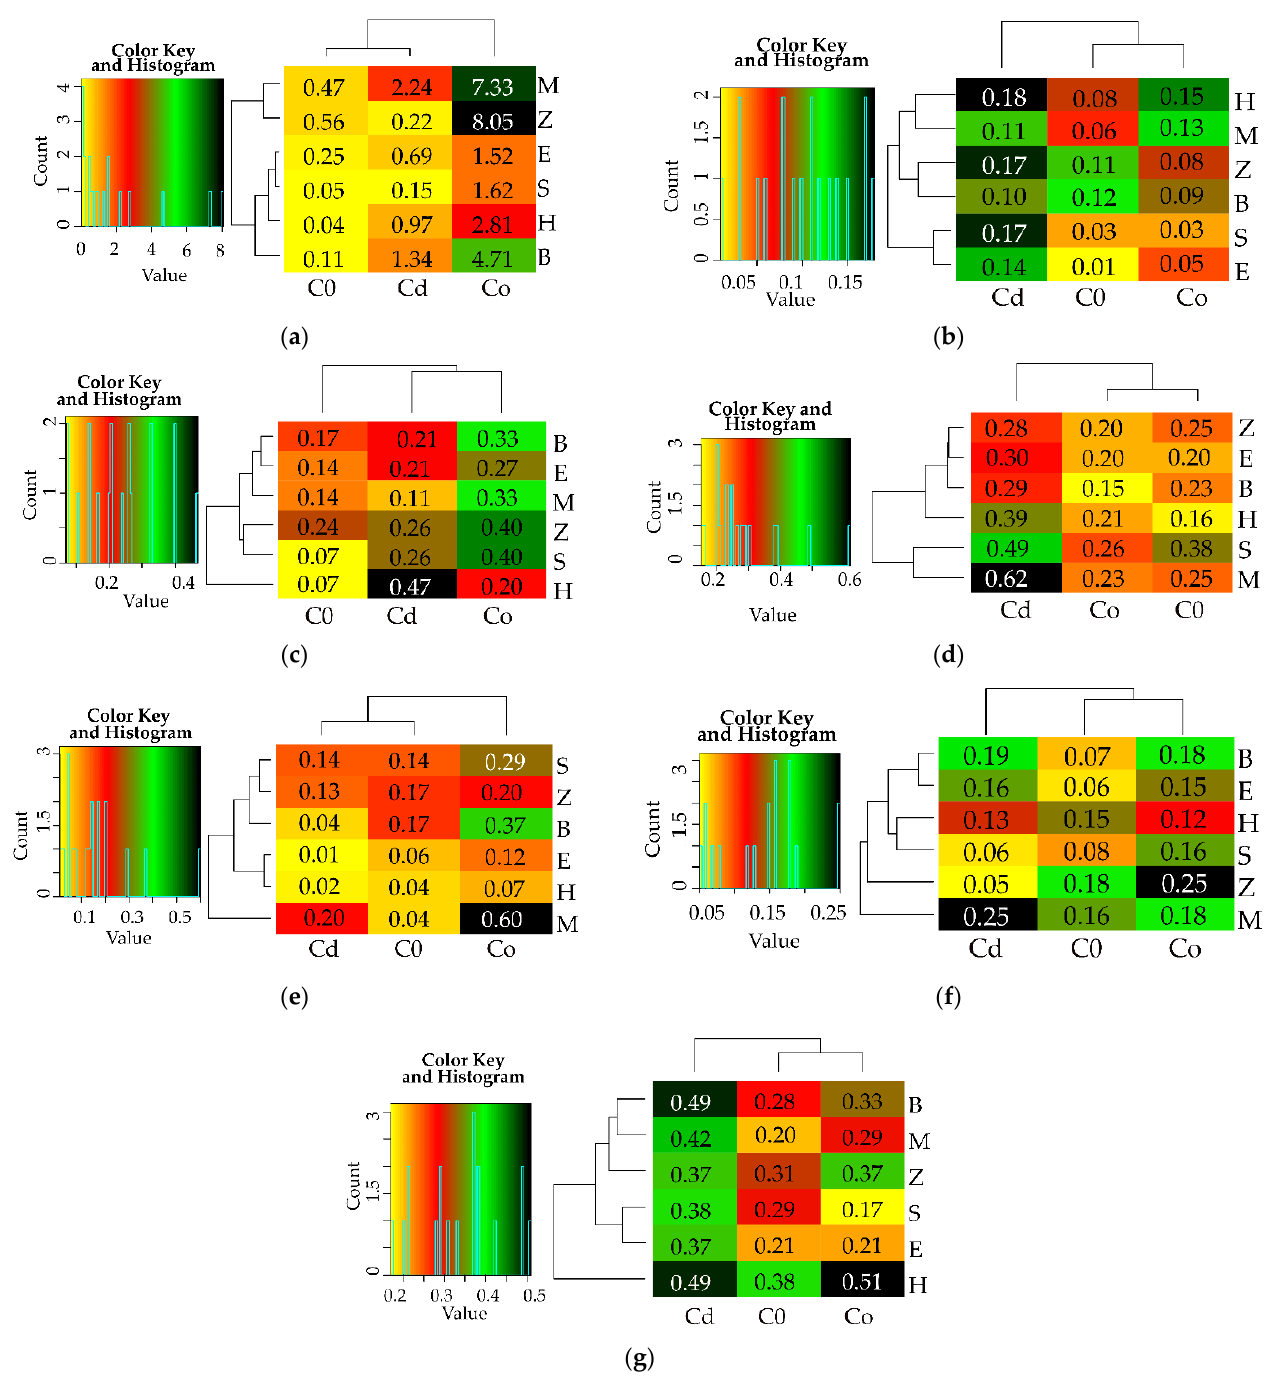
Figure 5. Indexes of the influence of sorbents on the activity of enzymes (IF Ad ). ( a ) dehydrogenases (Deh), ( b ) catalase (Cat), ( c ) urease (Ure), ( d ) acid phosphatase (Pac), ( e ) alkaline phosphatase (Pal), ( f ) arylsulfatase (Aryl), ( g ) β -glucosidase (Glu), M—molecular sieve, H—halloysite, S—sepiolite, E—